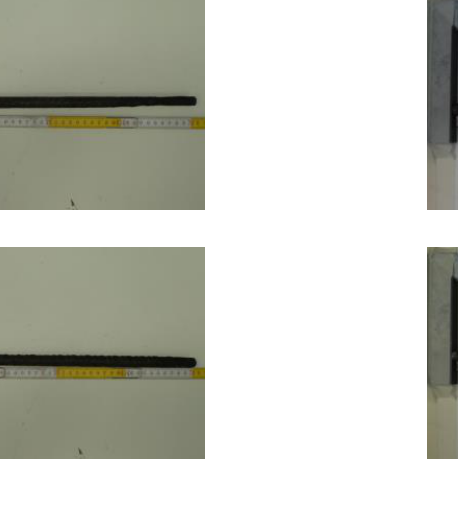
Figure 5. Corroded Rebars, Column B25. ( a ) Bar 1-2, ( b ) Bar 2-3, ( c ) Bar 3-4, ( d ) Bar 4-1.